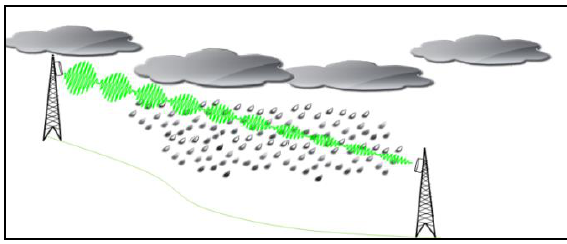
Figure 1. A single cellular microwave–link (CML) [6].